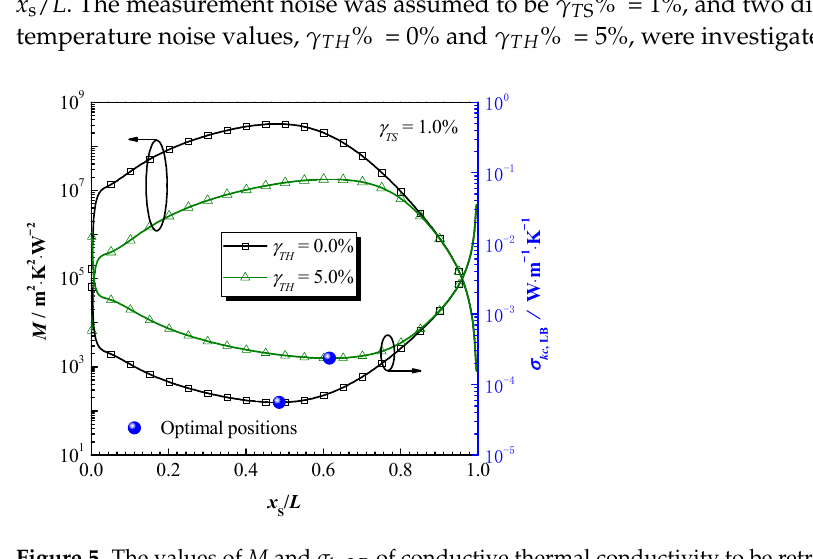
σ of conductive thermal conductivity to be retrieved as a func- Figure 5. The values of M and Figure 5. The values of M and σ k of conductive thermal conductivity to be retrieved as a function ,LB c k c ,LB of the dimensionless sensor position x s / L . tion of the dimensionless sensor position x s / L .